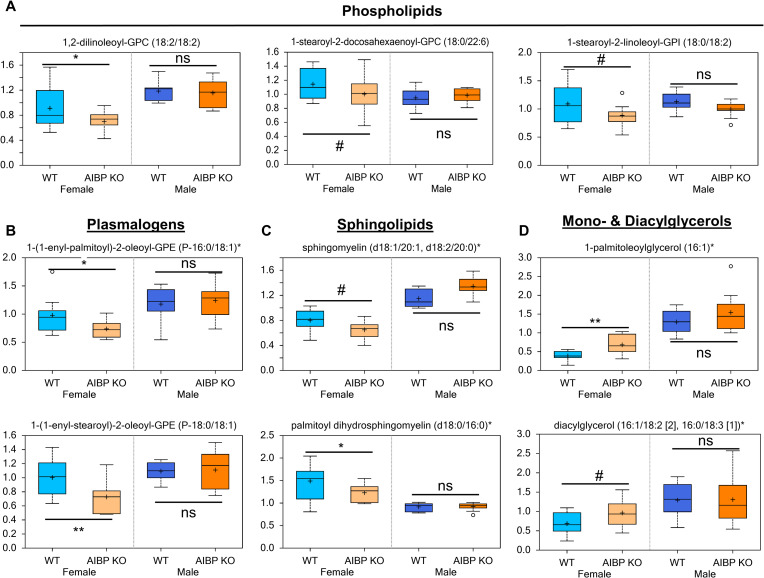
Effects of AIBP deficiency on complex lipid content.Plasma content of phospholipids (A), plasmalogens (B), sphingolipids (C), and mono- and diacylglycerols (D). **,p<0.01; *, p<0.05. #: 0.05<p<0.1. ns: not significant (p>0.1).